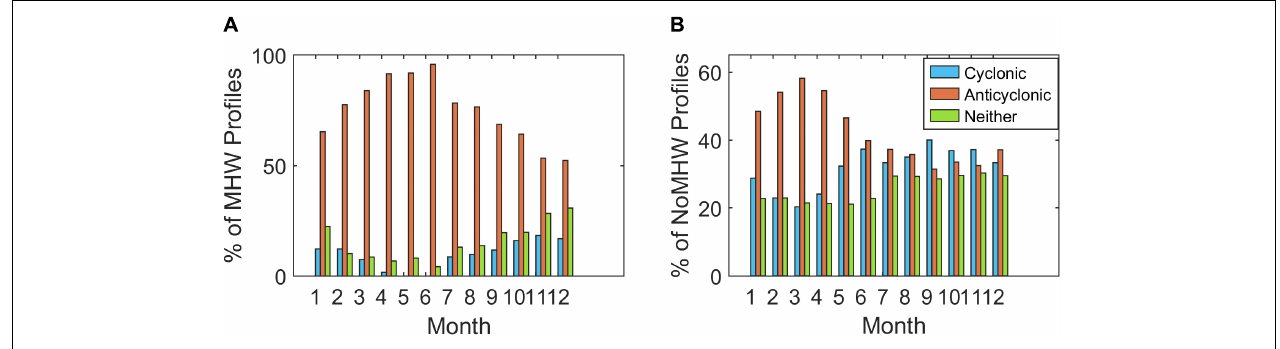
FIGURE 13 | Monthly distributions of Argo profiles in cyclonic (blue), anticyclonic (yellow) eddies or neither (red) during MHWs (A) and NoMHWs (B) .